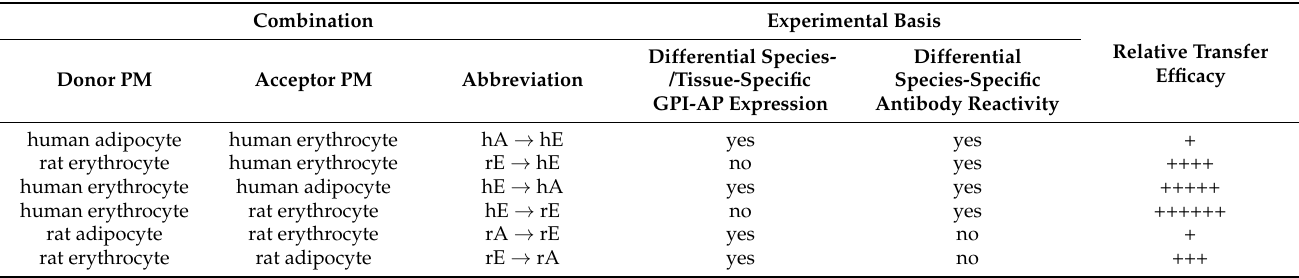
Table 1. Synopsis of the various combinations of donor and acceptor PM including the experimental basis enabling analysis of the transfer of GPI-APs, and the comparison of the relative transfer efficacy. Relative transfer efficacy is derived from Figure 4a (with 400 µ L of donor PM injected) and categorized as follows: +, 0.5–1.0 ∆ phase shift; +++, 2.0–3.0; ++++, 3.0–4.0; +++++, 5.0–6.0; ++++++,